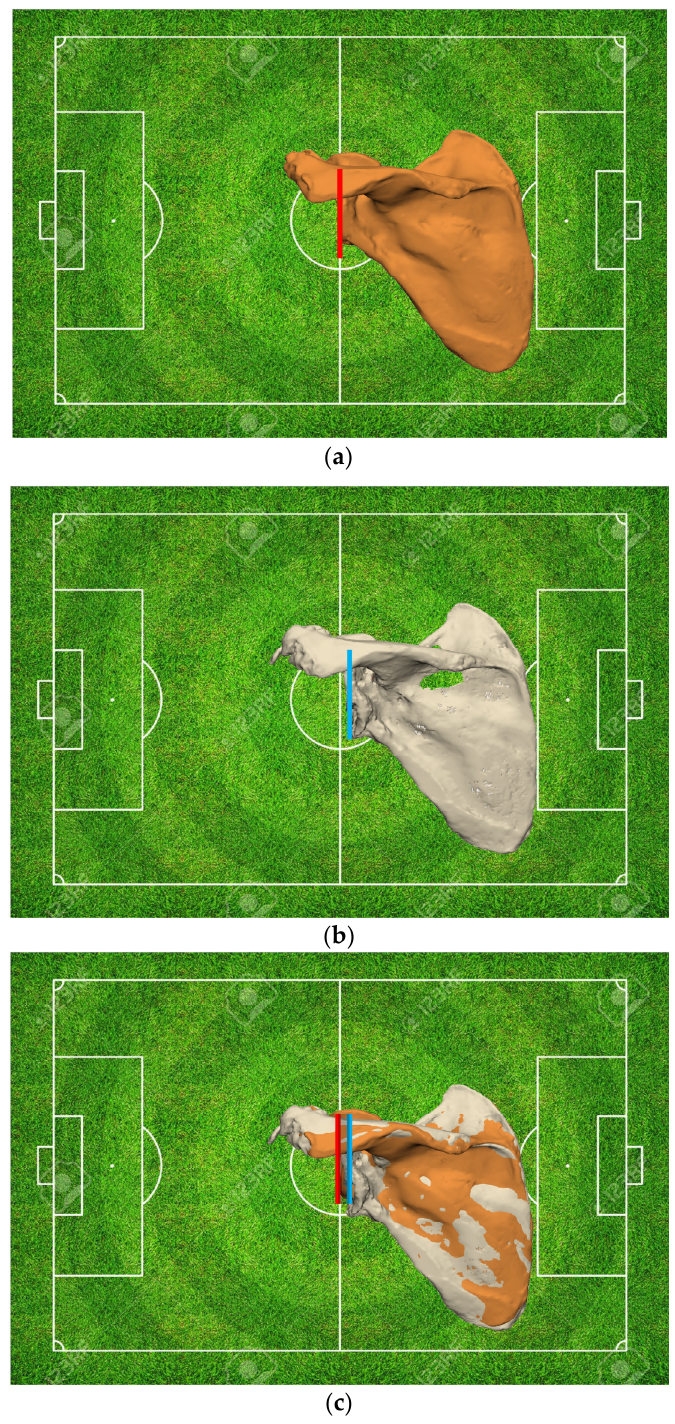
Figure 4. Evaluation of the premorbid anatomy allows to locate the native joint line (red line) ( a ) and the subsequent amount of medialization in the pathological anatomy (blue line) ( b ), thus providing information on the reconstruction necessary to restore the native joint line (distance between the blue and red lines) ( c ).